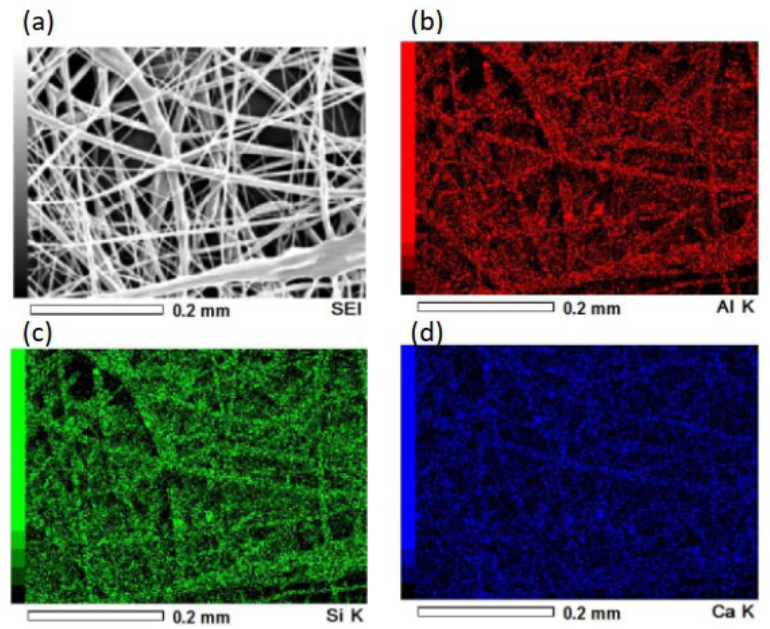
Figure 6. ( a ) Secondary electron image and EDS mapping image for ( b ) Al, ( c ) Si and ( d ) Ca of the composite sample.